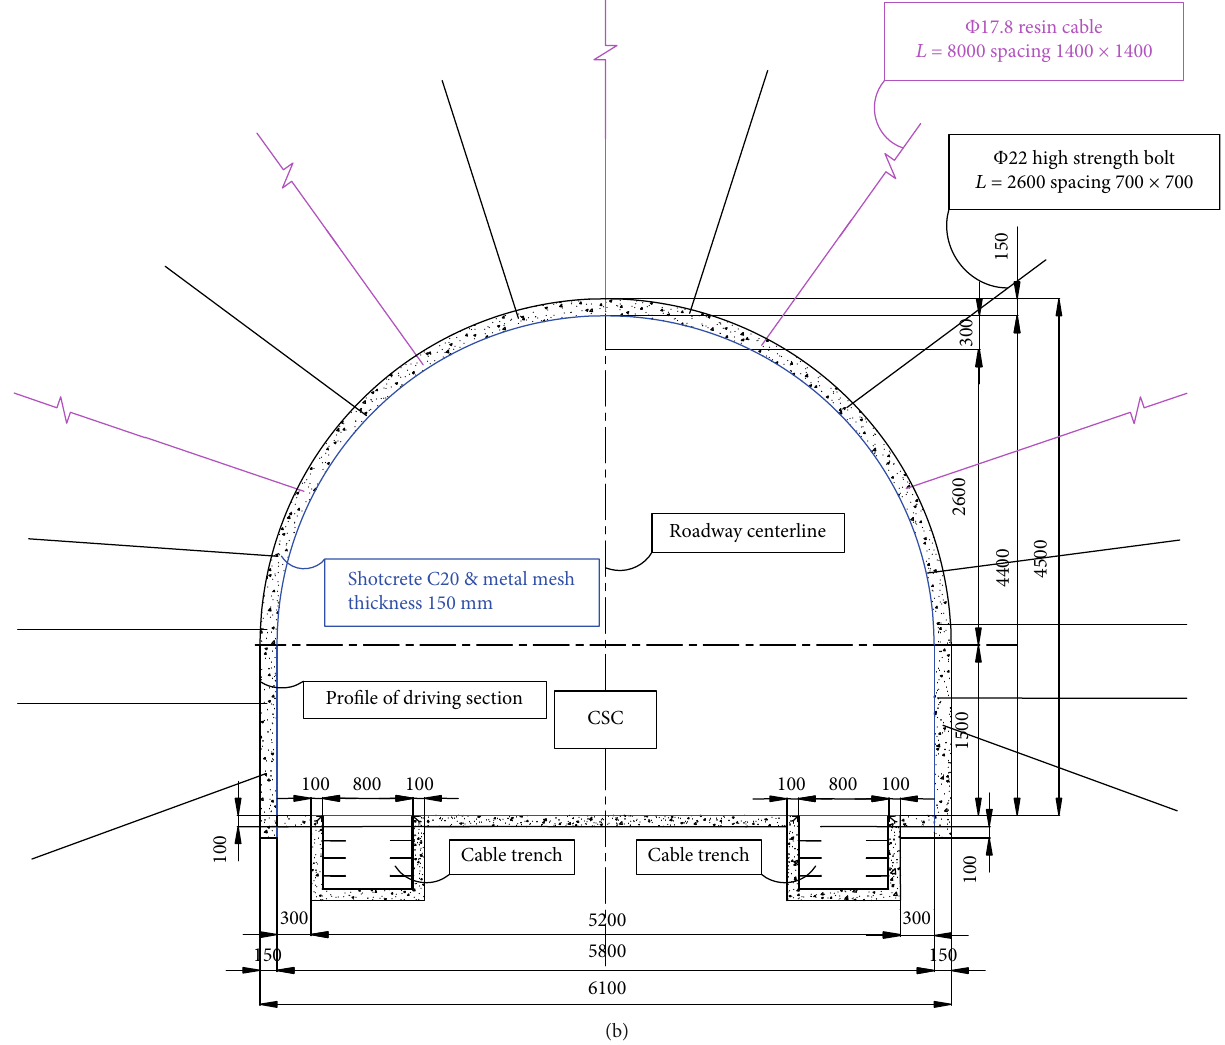
Figure 2: (a) Section and support parameters of MPC. (b) Section and support parameters of CSC.